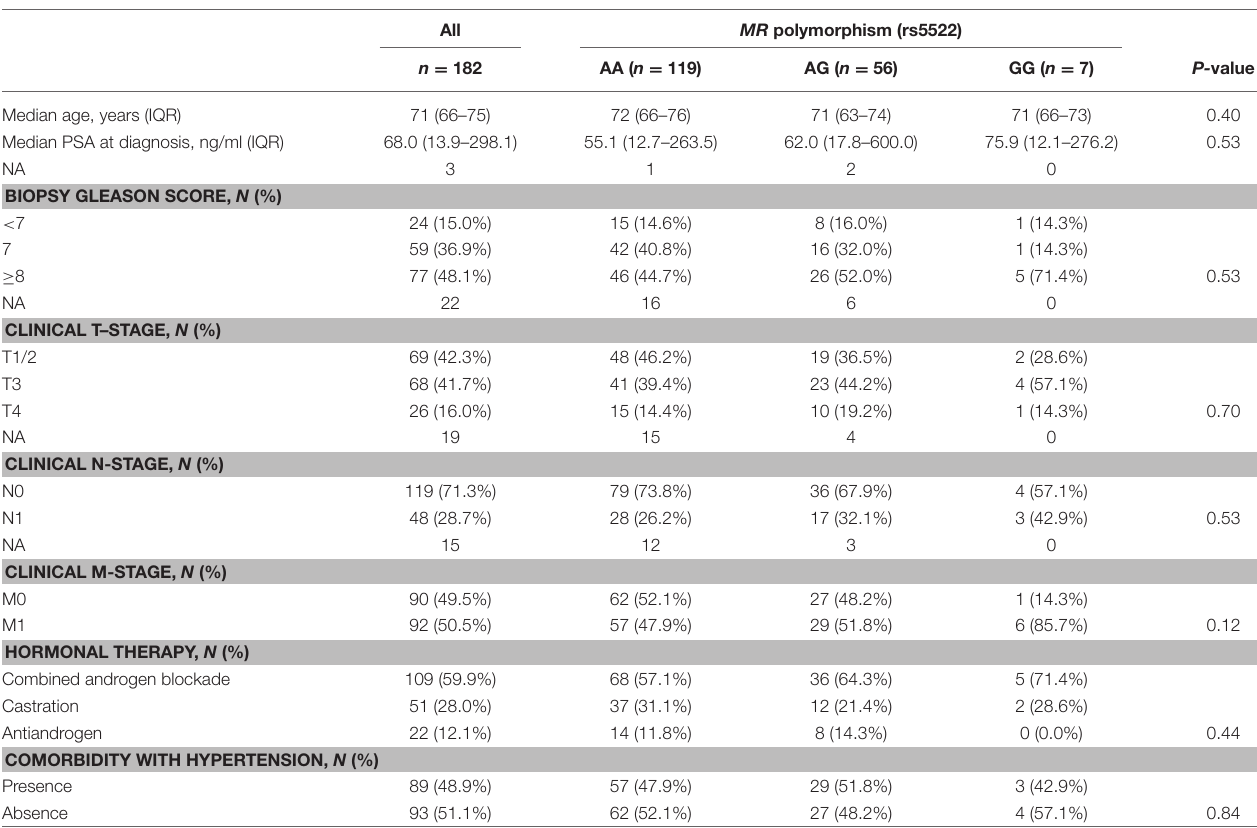
TABLE 1 | Patient characteristics among patients undergone ADT stratified by MR rs5522 polymorphism.